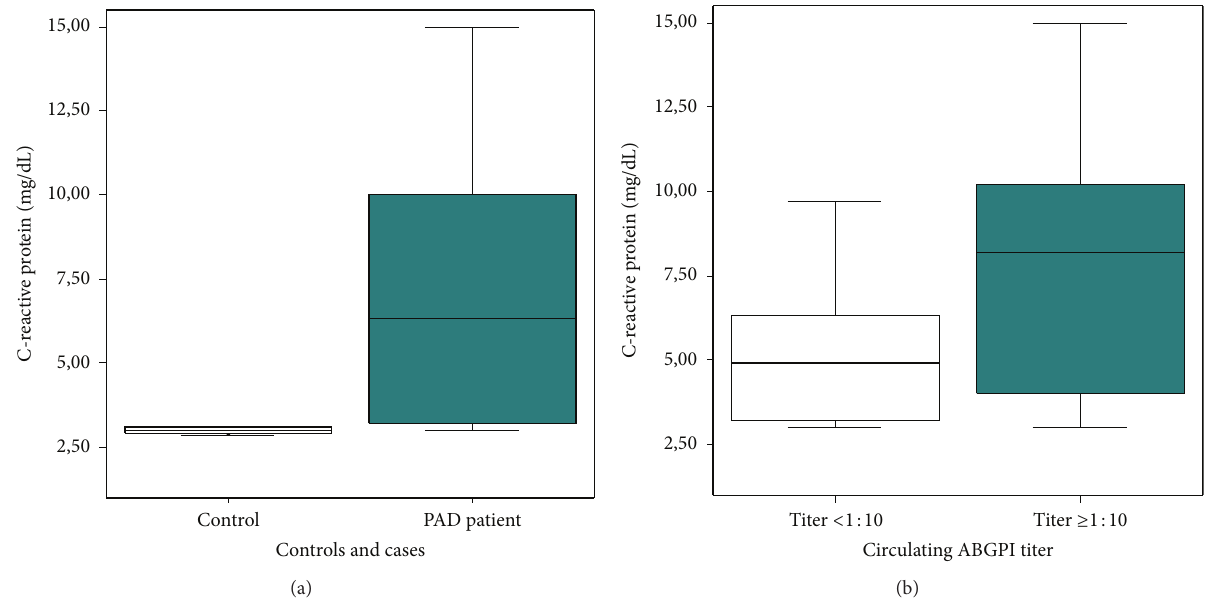
Figure 2: C-reactive protein (hsCRP) results. (a) Peripheral arterial disease patients showed higher hsCRP levels ( 𝑃 < 0.01 ). (b) We observed higher hsCRP levels in patients with circulating anti-beta2-glycoprotein I antibodies (ABGPI) titer ≥ 1:10 ( 𝑃 = 0.04 ).